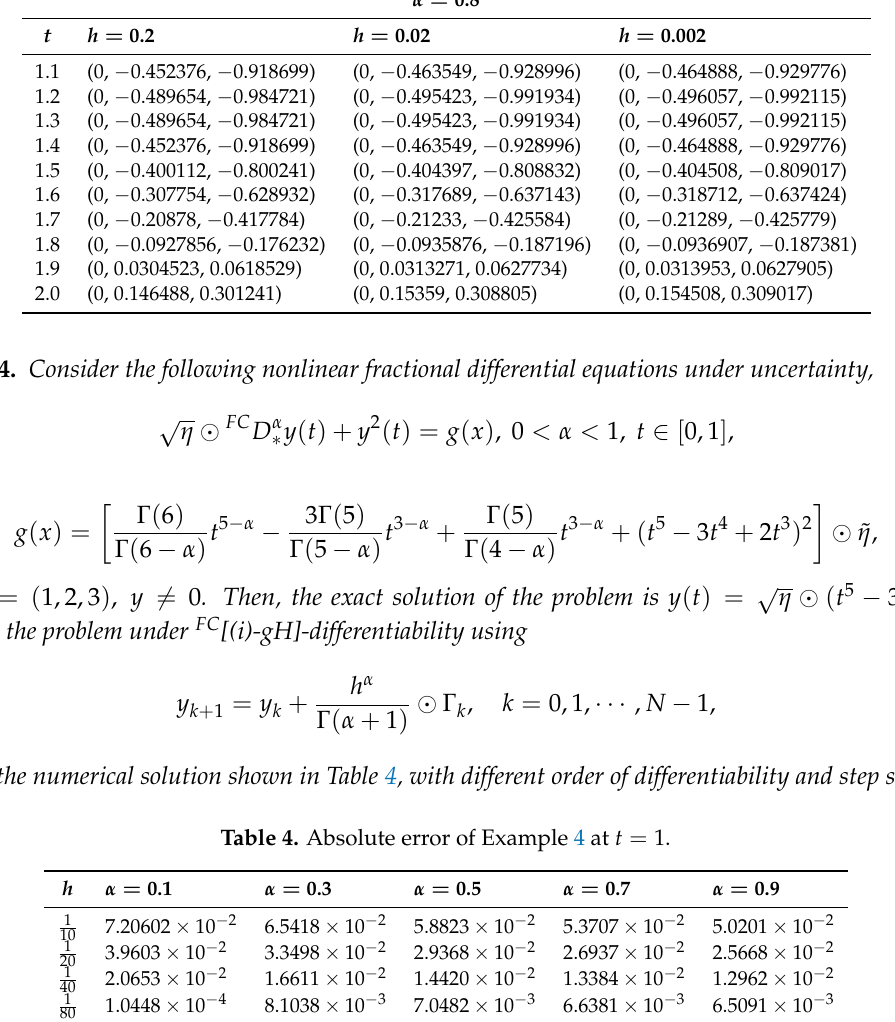
Figure 3. ( a ) The exact solution ( b ) the Caputo gH-derivative of solution defined in Example 3 for α = 0.8. Table 3. Numerical results of Example 3 for α = 0.8, h = 0.2,0.02,0.002 and various t . α = 0.8